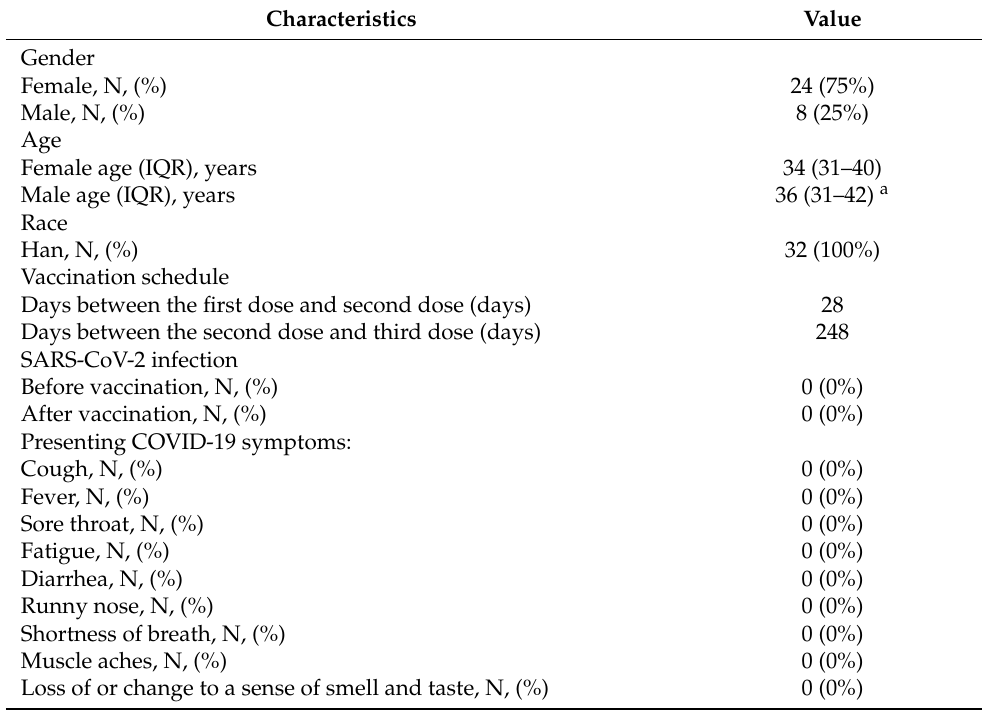
Table 1. Clinical Characteristics of 32 participants to whom three doses of CoronaVac Vaccine were